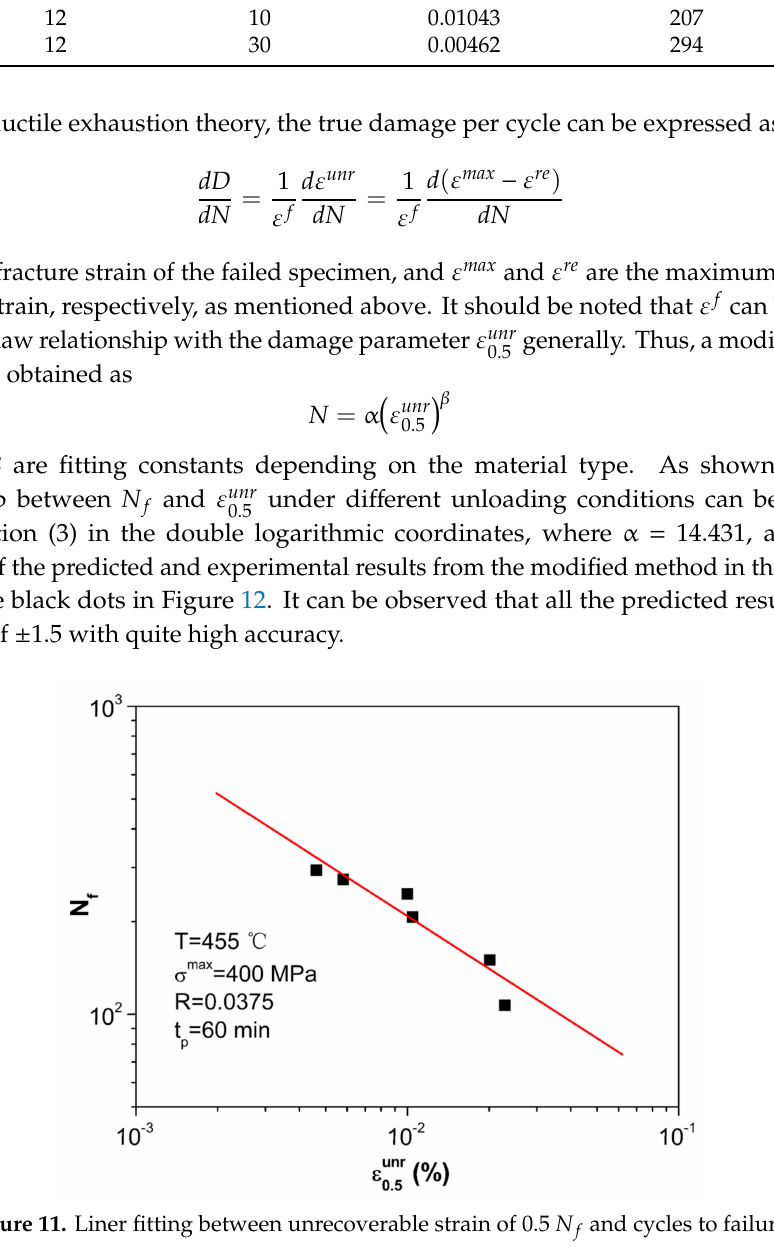
Table 4. Summary of the damage parameter of ε unr